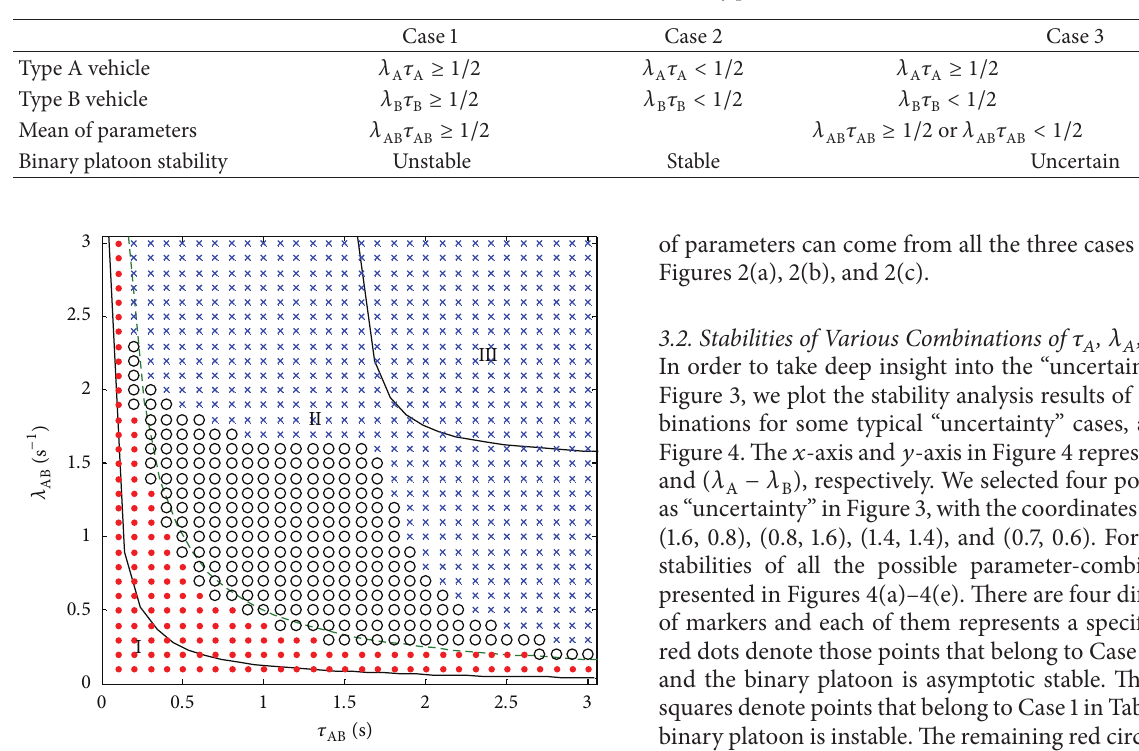
Table 1: Three cases of binary platoon.